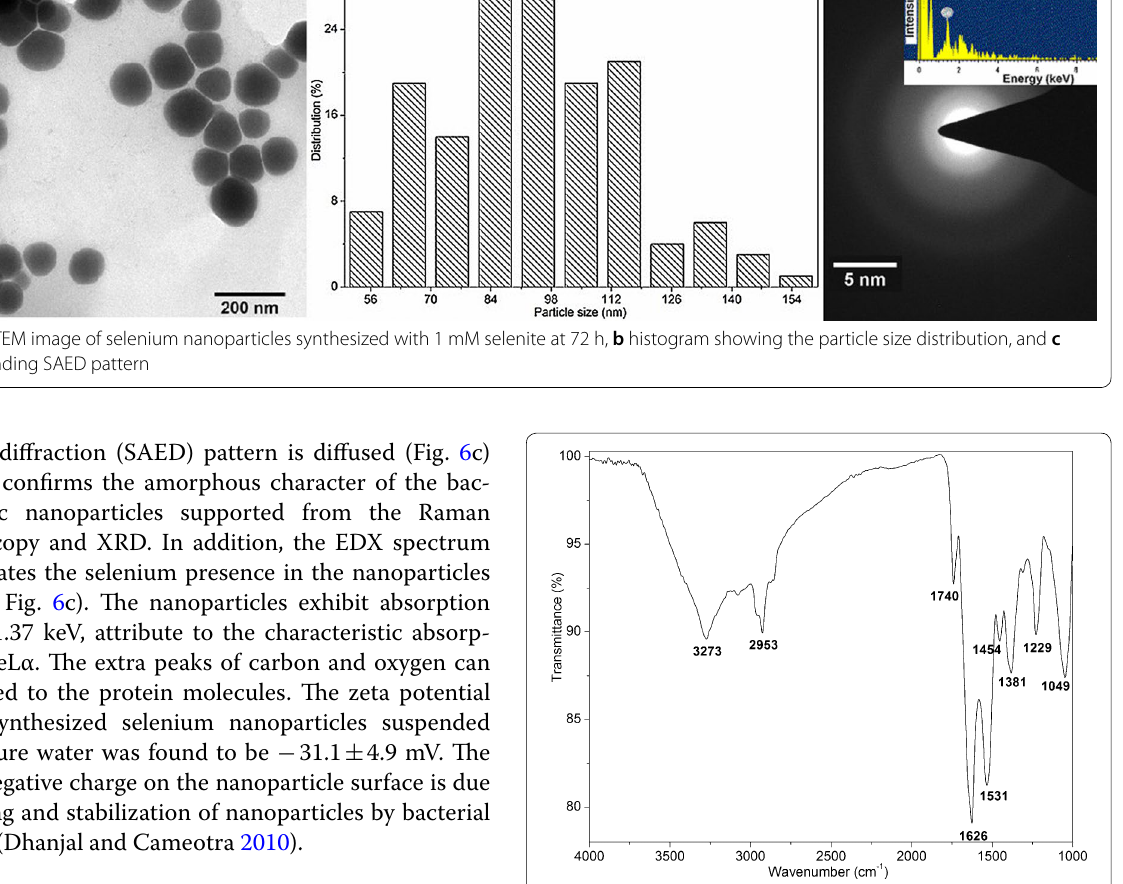
Fig. 7 FTIR spectrum of freeze-dried selenium